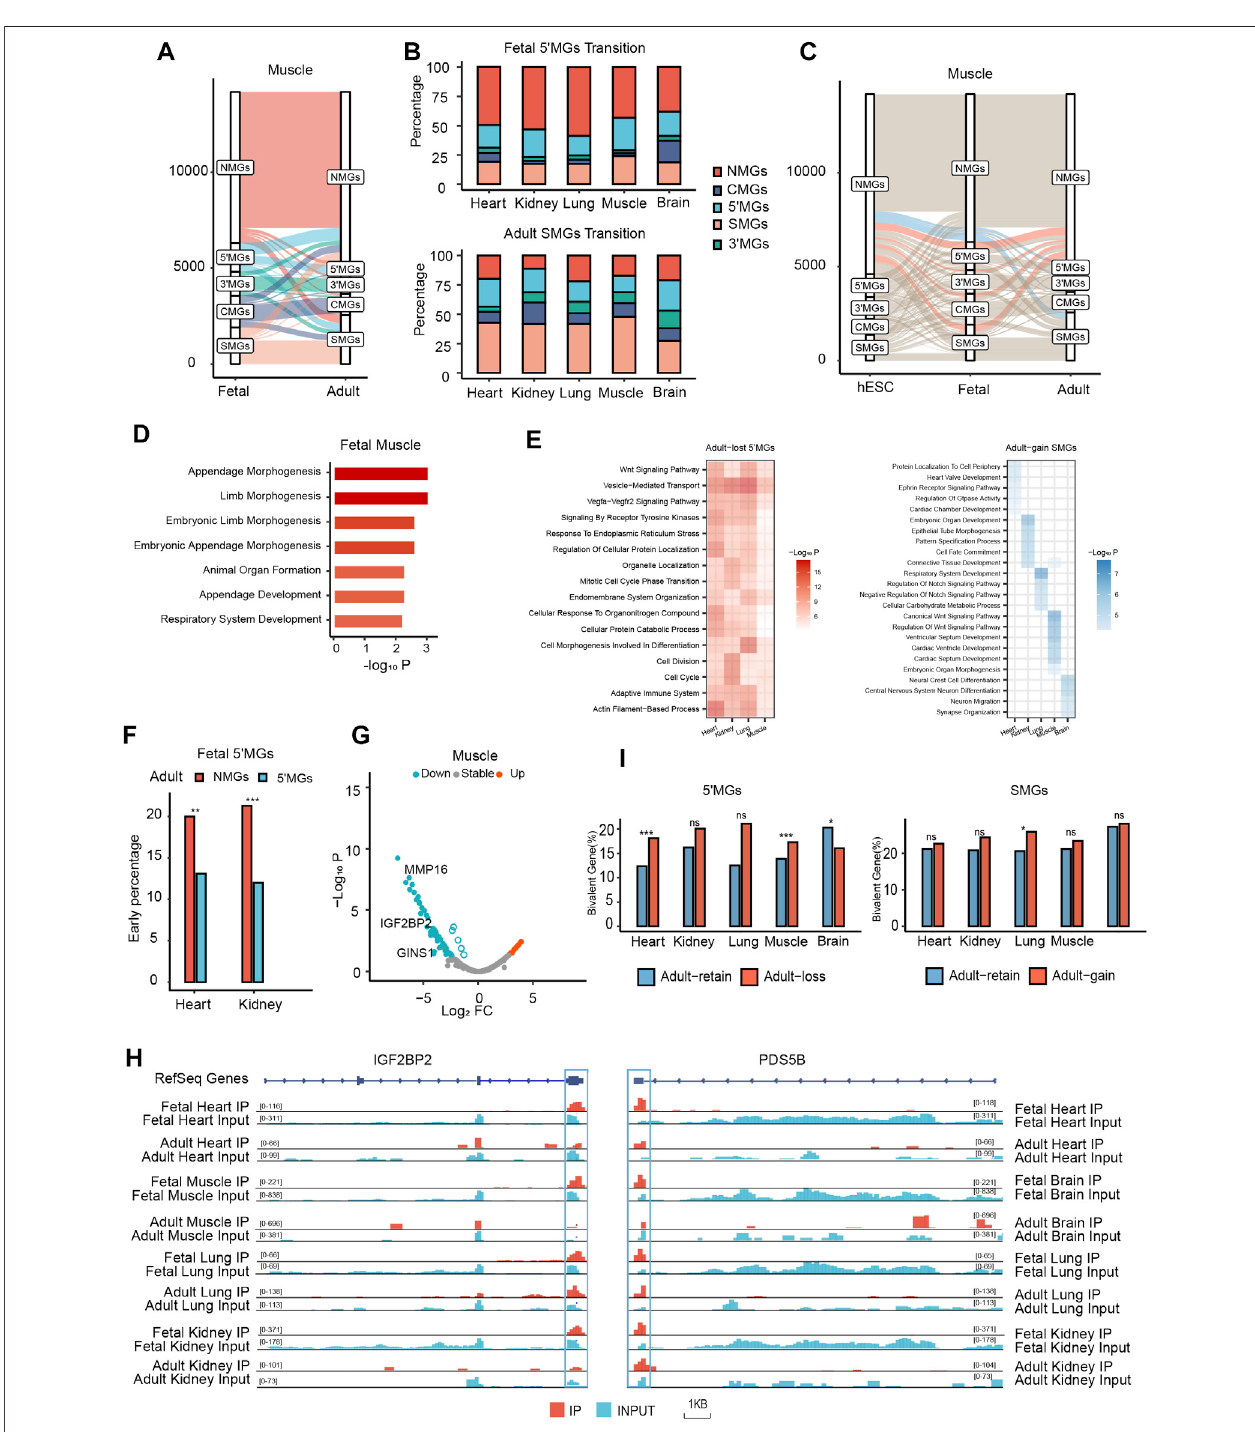
FIGURE 4 | Dynamic m6A topological transition during mammalian tissue development which was associated with tissue development. (A) The m6A topological transition between human muscle tissue in fetal and adult stages. (B) The percentage of fetal 5 ′ MGs transited to adult gene groups and the percentage of adult SMGs transited from fetal gene groups across all human tissues in fetal and adult stages. (C) The transition between three developmental stages, hESC, fetal, and adult of human muscle tissue. (D) Bar plot showing function enrichment analysis of muscle fetal-speci fi c m6A genes. Color key from white to red indicates − Log 10P . (E) Heatmap showing function enrichment analysis ofadult-loss 5 ′ MGs (Left) and adult-gain SMGs (Right) across tissues. Color key from white to red indicates − Log 10P in adult-loss 5 ′ MGs and from white to blue indicates − Log 10P in adult-gain SMGs. (F) The distribution of early genes in adult-loss and adult-retain 5 ′ MGs across human heart and kidney tissues ( χ 2 test, *** p value < 0.001, ** p value < 0.01). Those genes with signi fi cant decreased expression during development were classi fi ed as